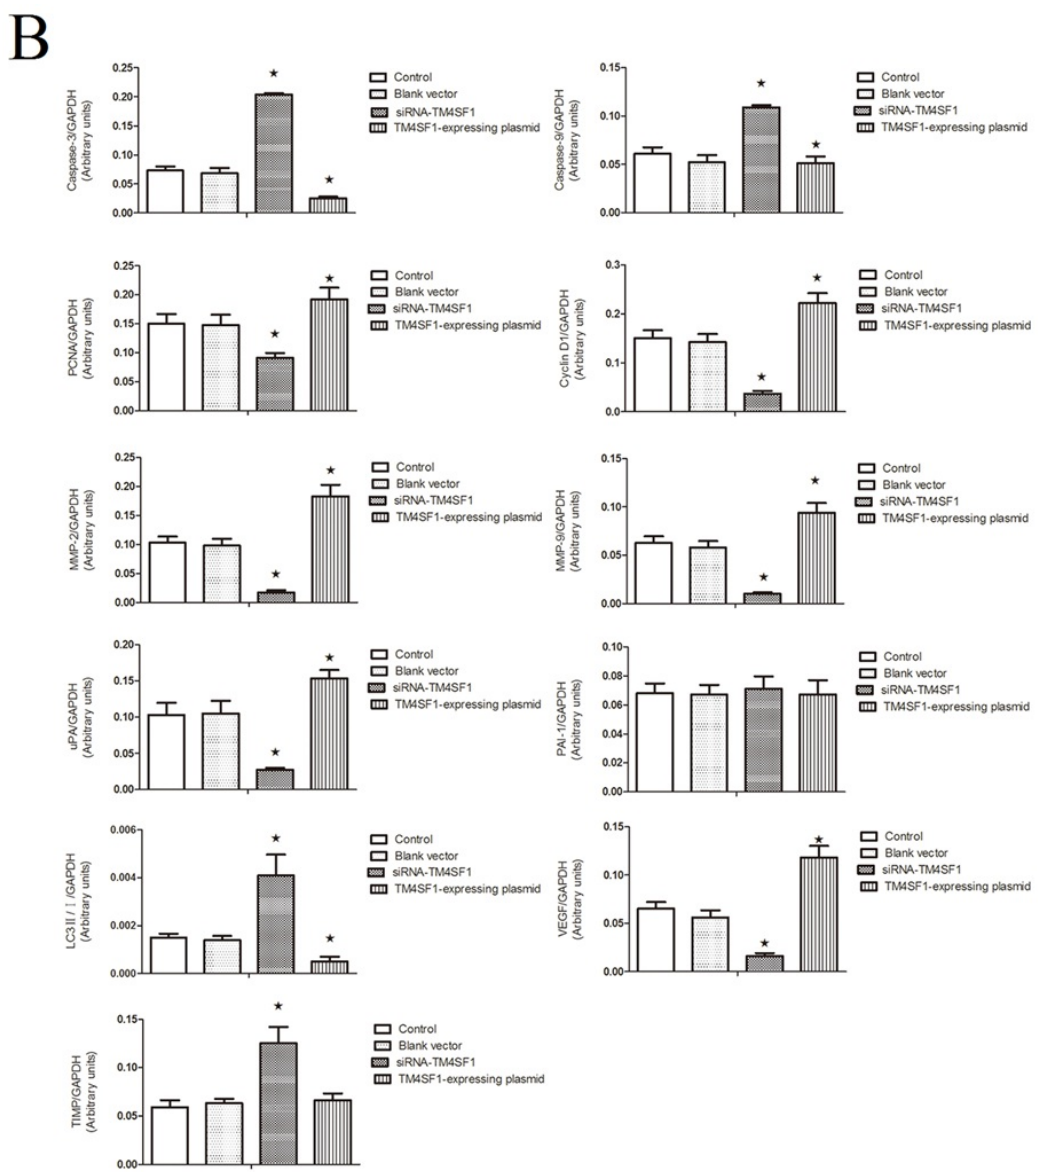
Figure 3. TM4SF1 overexpression reduced the protein expression of caspase ‐ 3 , caspase ‐ 9 , and LC3 ‐ II in HepG2 cells, but increased expression of PCNA , cyclin D1, MMP ‐ 2 , MMP ‐ 9 , uPA , and VEGF . TM4SF1